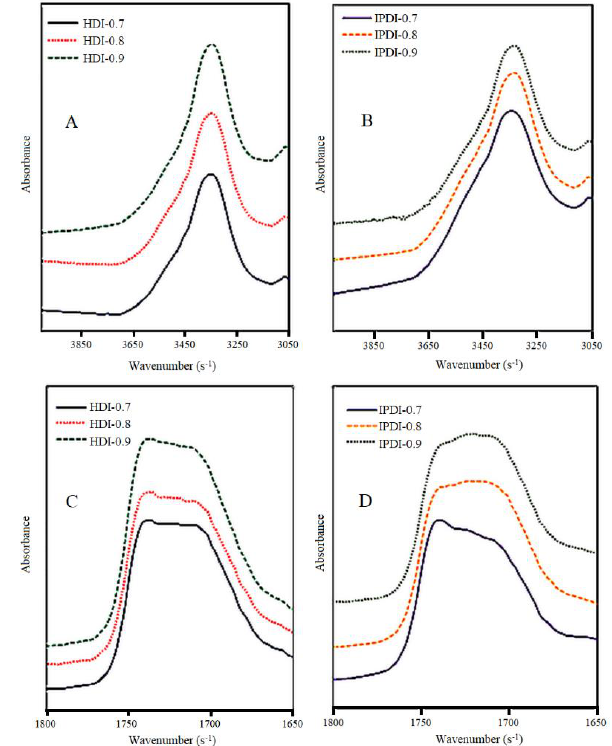
Figure 5. FTIR spectra of COOH-containing prepolymers synthesized using different isocyanates and NCO/OH mole ratios in the 4000–3050 cm − 1 range for ( A ) hexamethylene diisocyanate (HDI) and ( B